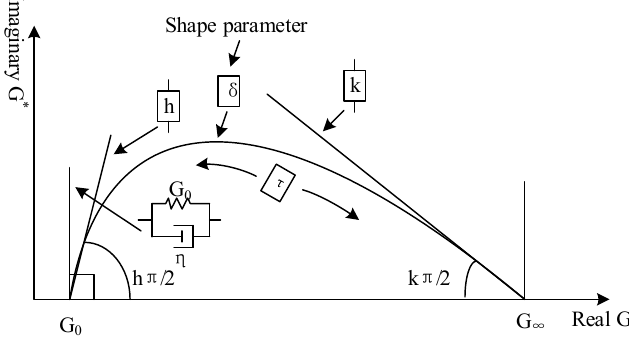
Figure 2. Visualization of the parameters of 2S2P1D model.